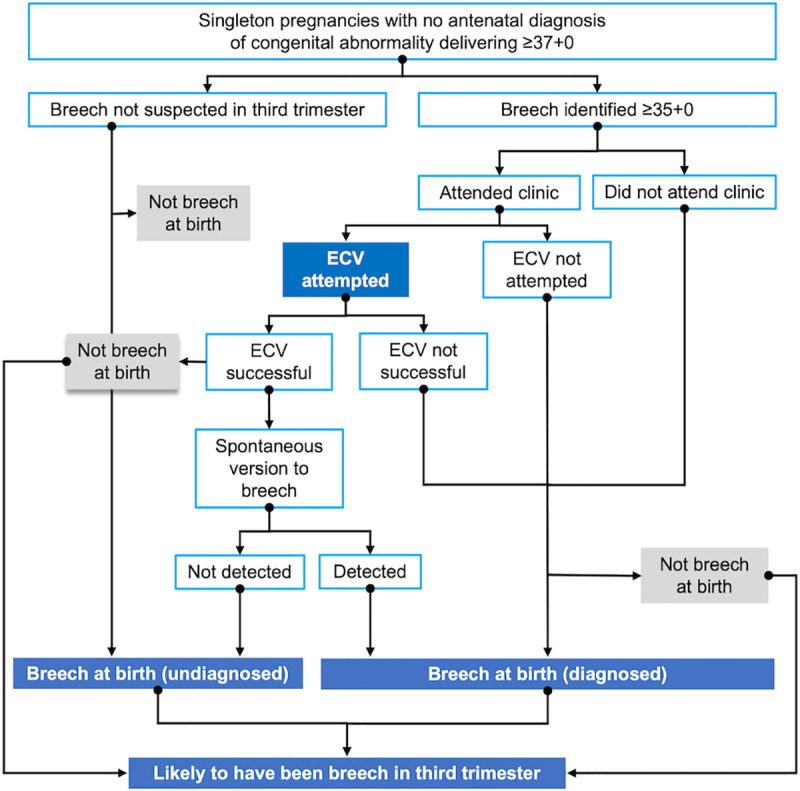
Pathways of the breech fetus in the third trimester. ECV, external cephalic version.